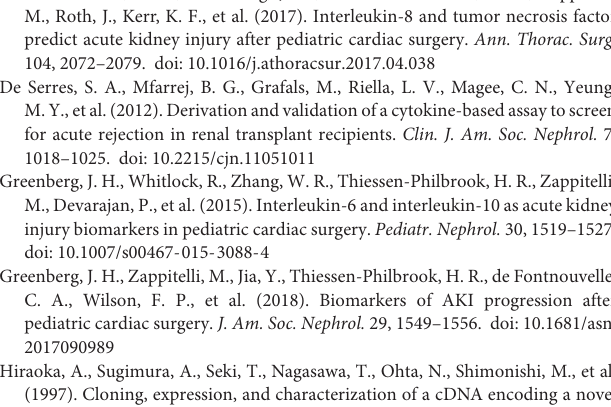
Supplementary Table S1 | Bonf_P-value between AKI and